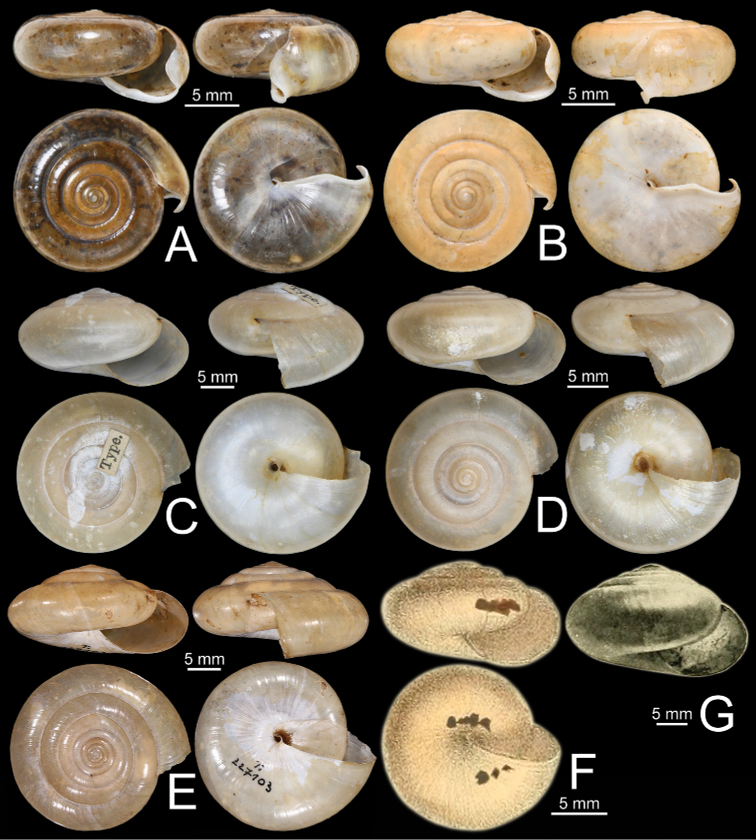
Shells of Sarika spp. A, BSarika
gratesi sp. nov. A holotype CUMZ 7275 and B paratype CUMZ 7276 C, DS.
pumicata syntype NHMUK 1893.2.4.980–981 ES.
ochtogyra holotype SMF 227103/1 FS.
benoiti modified from Crosse and Fischer (1863)GS.
rex modified from Preston (1909).